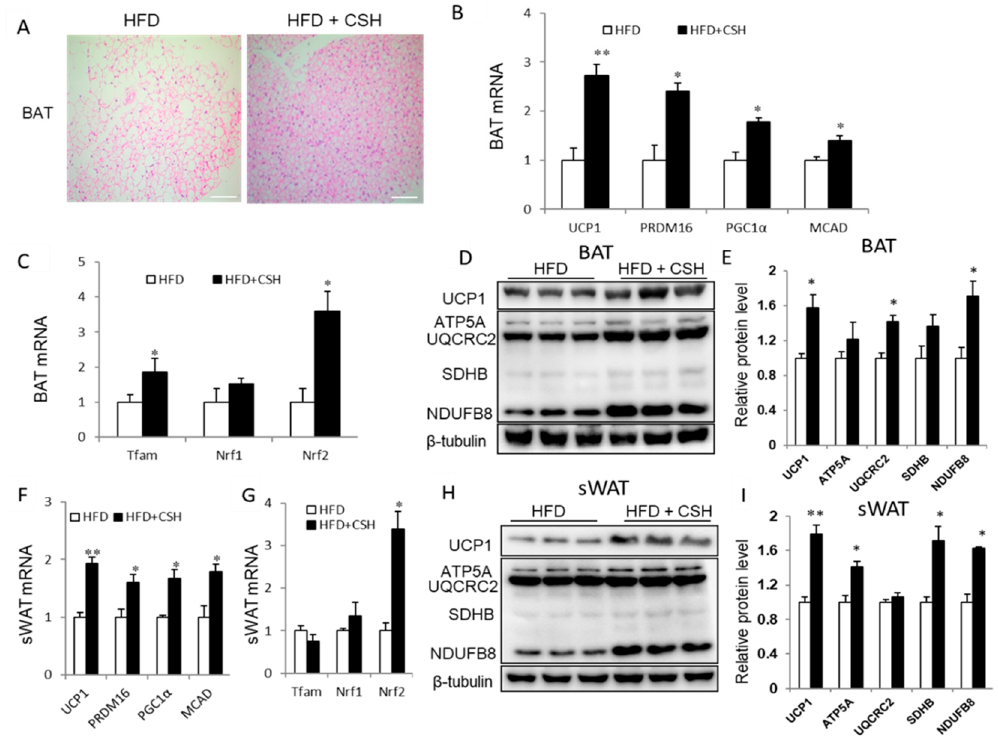
Figure 3. WECS activates BAT and induces browning of SWAT. Histology analysis showed that WECS treatment decreased the lipid droplets in the BAT( A ). Scale bars, 100 µ m. Besides, WECS treatment upregulated the expression of thermogenic genes and some mitochondrial genesis genes in BAT ( B and C ) and sWAT ( F and G ) in HFD mice. Besides, WECS upregulated the expression of UCP1 and some proteins related to oxidative phosphorylation in BAT ( D ) and sWAT ( H ). Relative protein levels of UCP1 and OXPHOS in BAT and sWAT ( E and I ). Bars represent the mean + SEM, n = 3–5. * p < 0.05, ** p < 0.01 compared with HFD control.